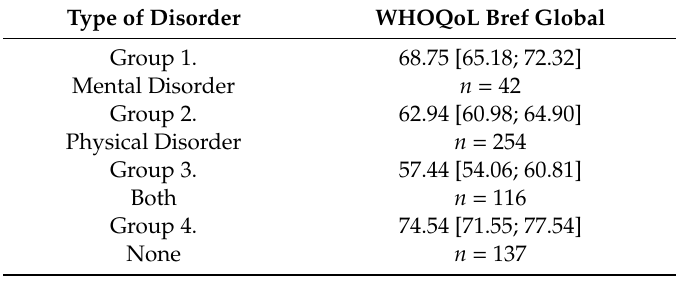
Table 3. Mean scores by type of disorder on the WHOQoL Bref * global scale.